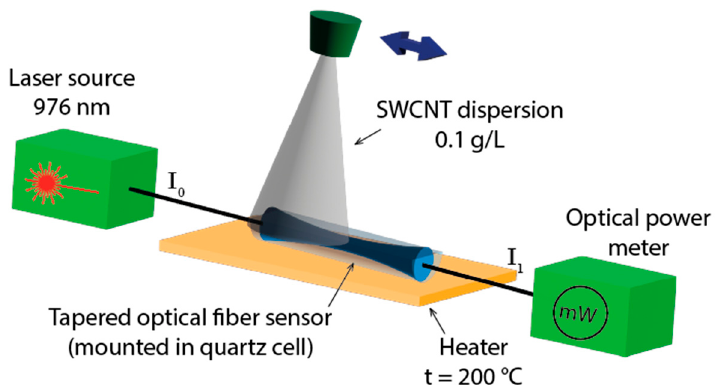
Figure 1. The scheme of the aerosol layer-by-layer deposition.